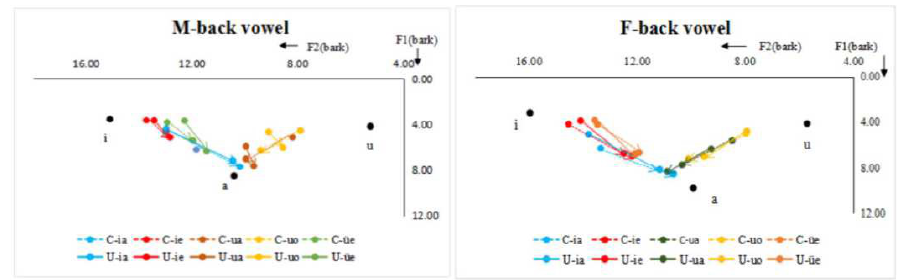
Fig. 5 Vowel chart of back vowel acoustics for intermediate level learners and standard